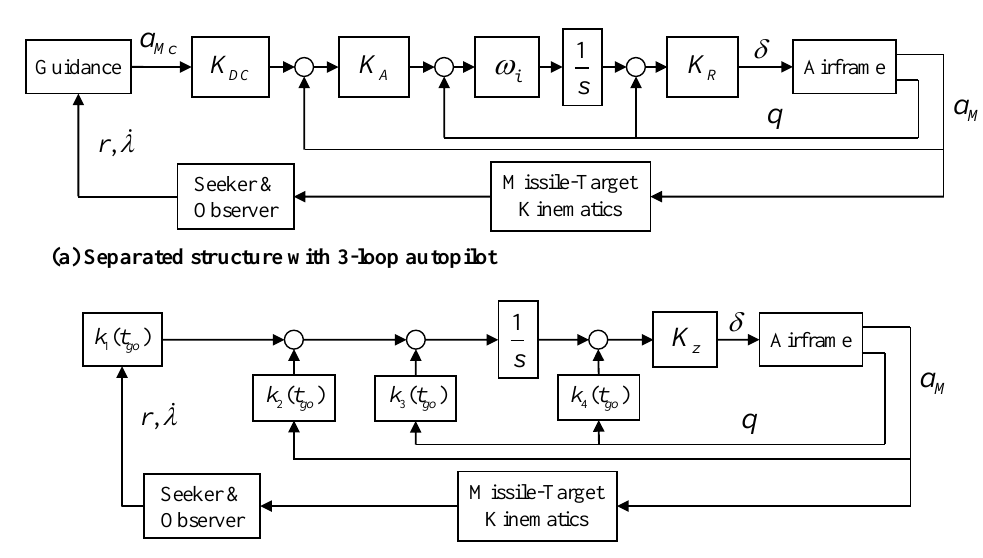
Figure 2. Guidance and autopilot